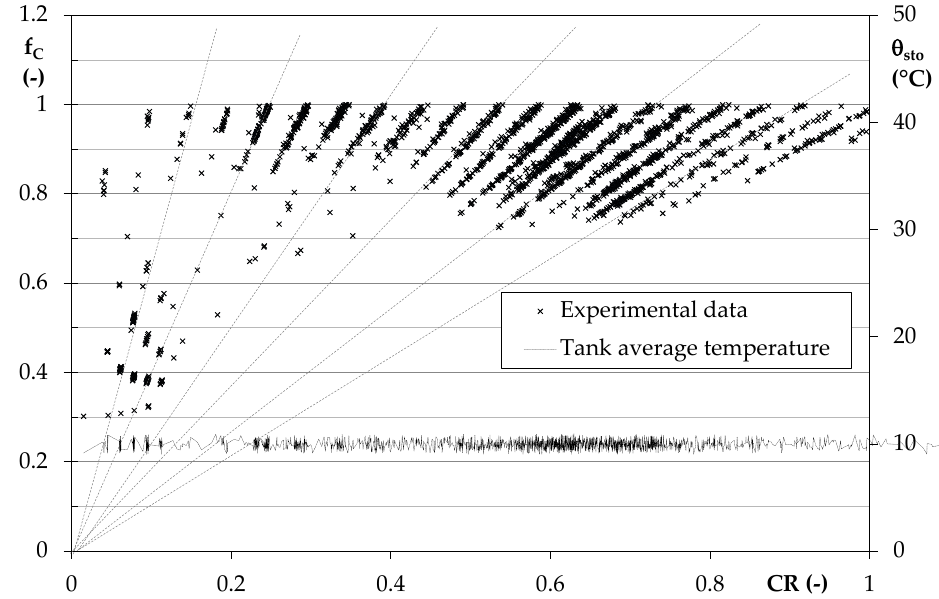
Figure 6. Average tank temperature and correction factors f C determined in the summer from the experimental data.